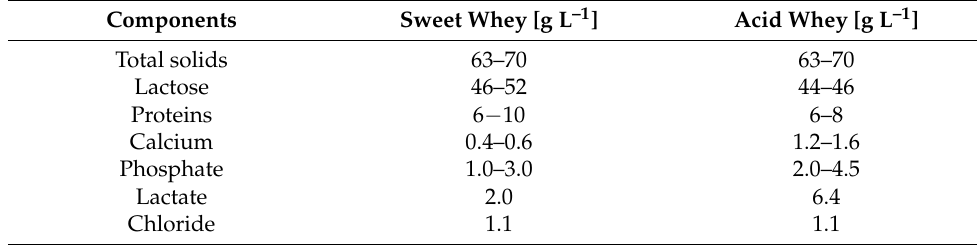
Table 2. Typical composition of whey.